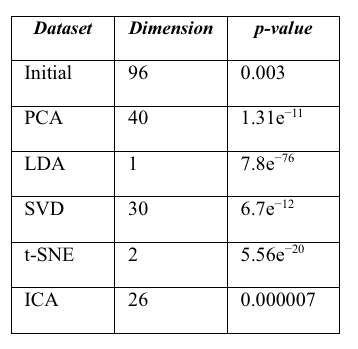
Table 2. Best P-value of initial and reduced databases